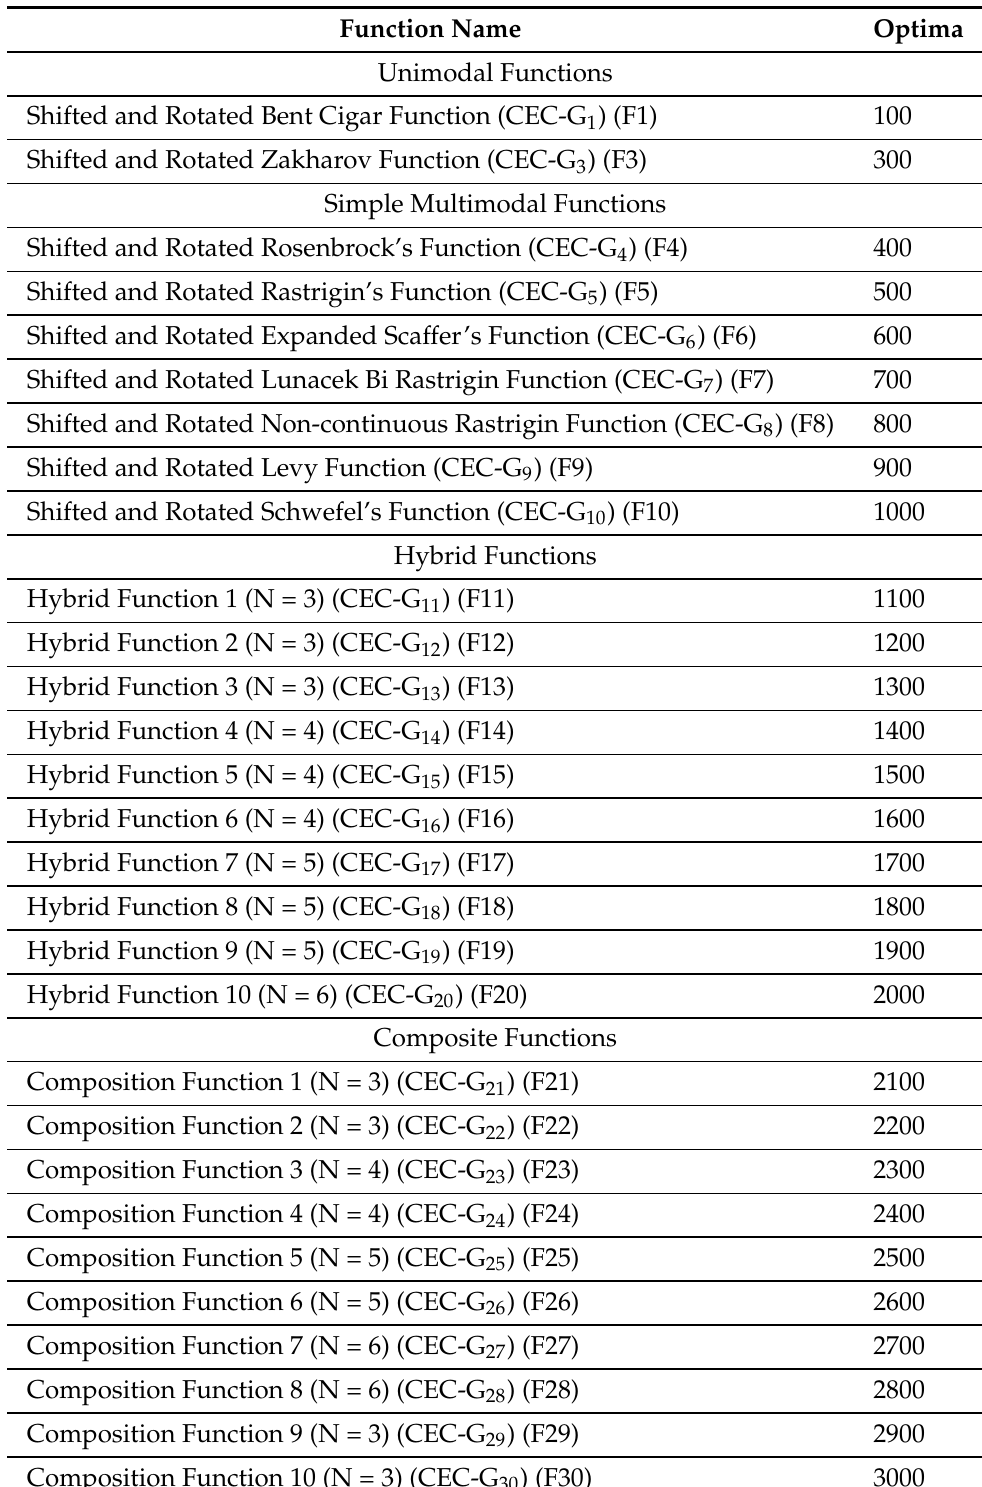
Table 2. Details of CEC-2017 (Benchmark Suite